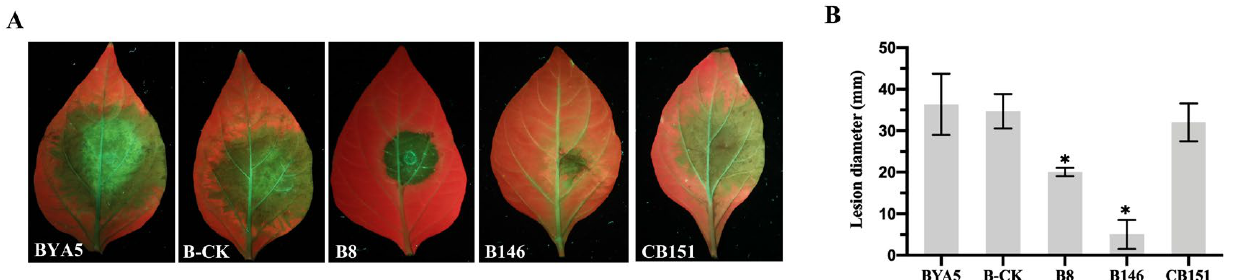
Figure 6. Effects of PcSTT3B on virulence in P. capsici . ( A ) Visualized lesion symptoms on peppers. ( B ) lesion diameters on peppers. Pepper leaves were inoculated with ∼ 100 zoospores and assessed after 3 days. All experiments were replicated three times, each had a similar result. Asterisks indicate significant deviations from the WT strain BYA5 strain (*, p < 0.05). Data represent the mean ± standard deviations from three biological